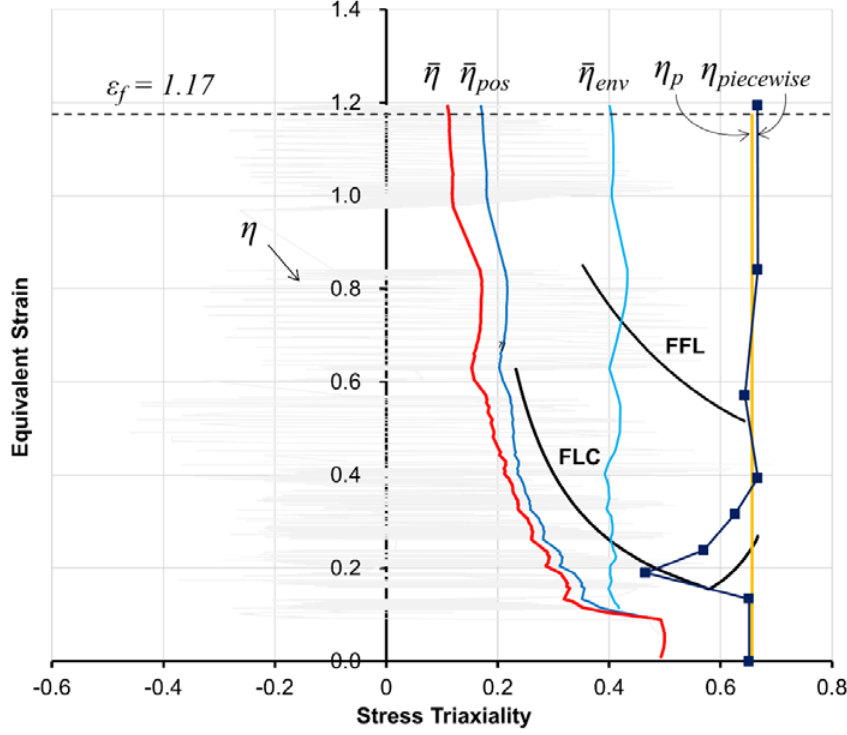
Figure 13. Finite element computed non-proportional, cyclic path of point A (Figure 9) with several ε = f ( η ) evolutions obtained from different assumptions and integral forms of stress-triaxiality. As seen, the ε = f ( η ) reference evolution based on a linear, proportional, equal biaxial stress triaxiality ratio η p consists of a vertical line η p = 0.66 that extends up to an effective strain value at fracture ε f = 1.17 located far above the FFL. The other ε = f ( η )